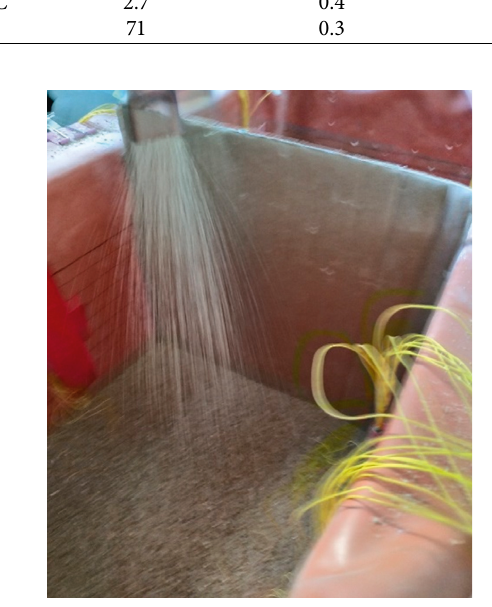
Figure 4: Fujian sand made by air pluviation technique.